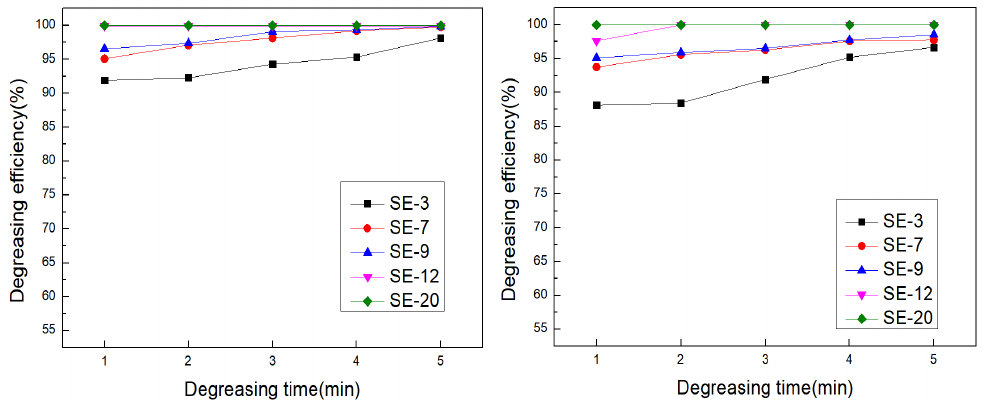
Figure 3. Degreasing efficiency over time for the various surfactants at degreasing solution temperatures of 70 °C ( left ) and 80 °C ( right ).